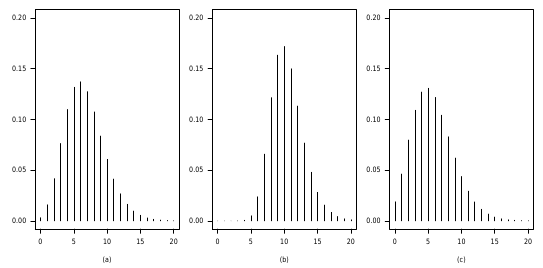
( θ ) } , in panel (a), where η = 6.67 and i ( θ , α ) } , for η = 6.67, θ = 0.75, and α = i